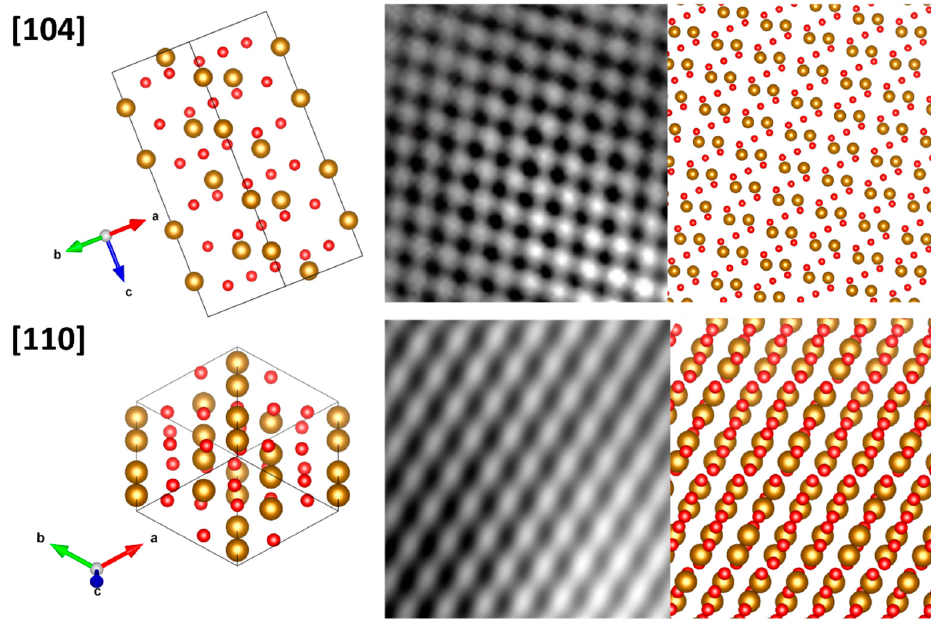
Figure 6. HRTEM images showing the atomic lattice fringes of hematite, which precisely coincide with the 3D lattice model along the [104] and [110] directions of rhombohedral hematite.